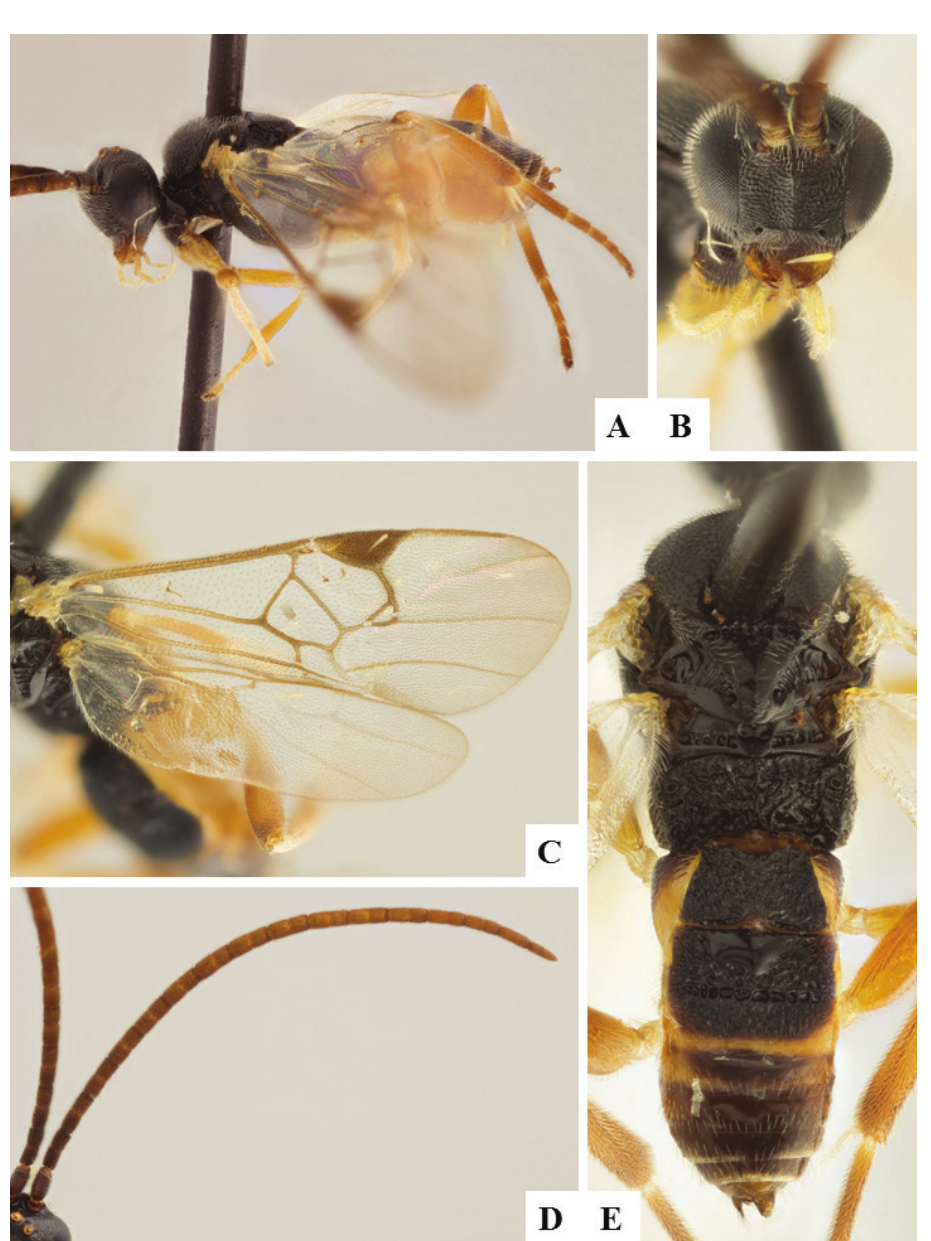
Figure 28. Microgaster gelechiae. A Habitus, lateral B Head, frontal C Wings D Antenna E Mesosoma and metasoma,